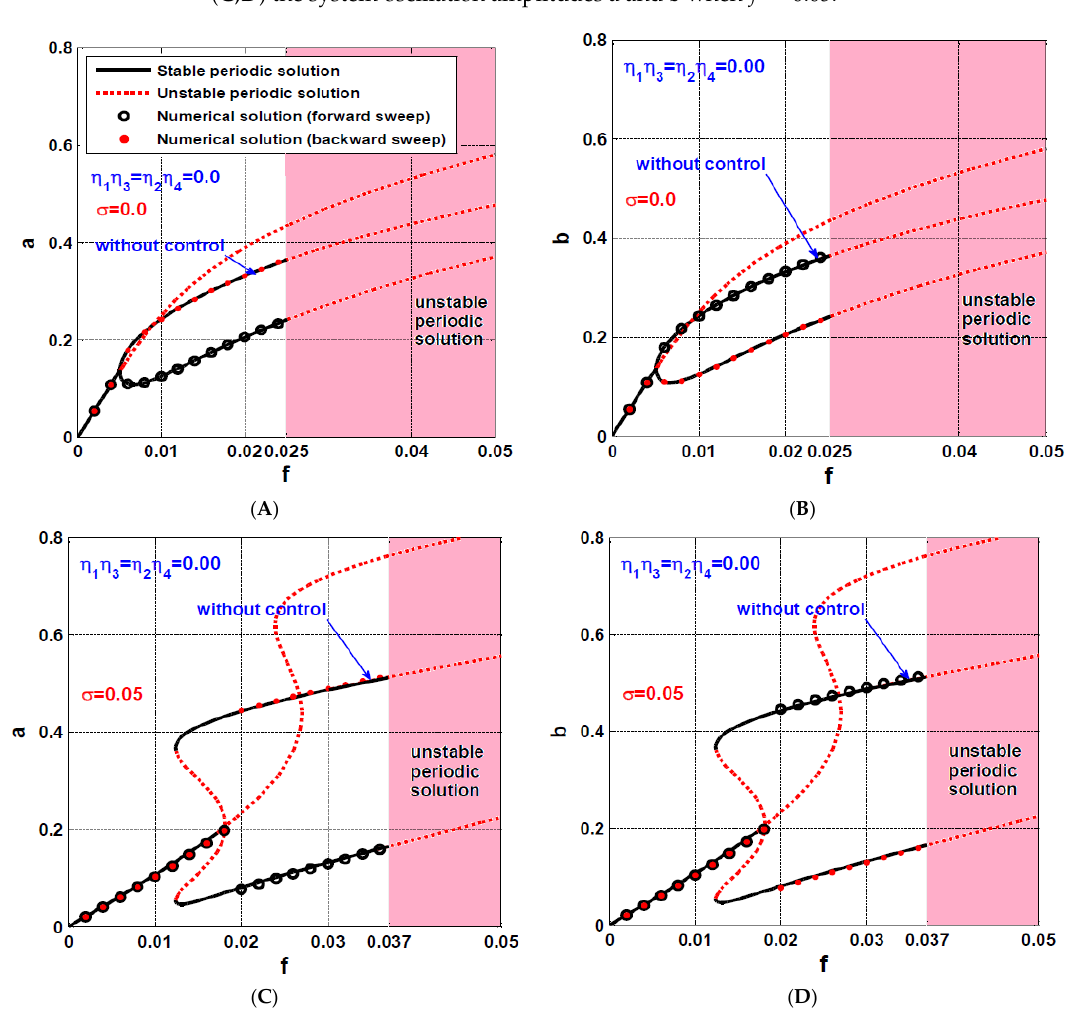
Figure 4. The rotor system f response curve at two different values of the rotor spinning speed ( Ω = ω + σ ): ( A , B ) the system oscillation amplitudes a and b when σ = 0.0, and ( C , D ) the system oscillation amplitudes a and b when σ =